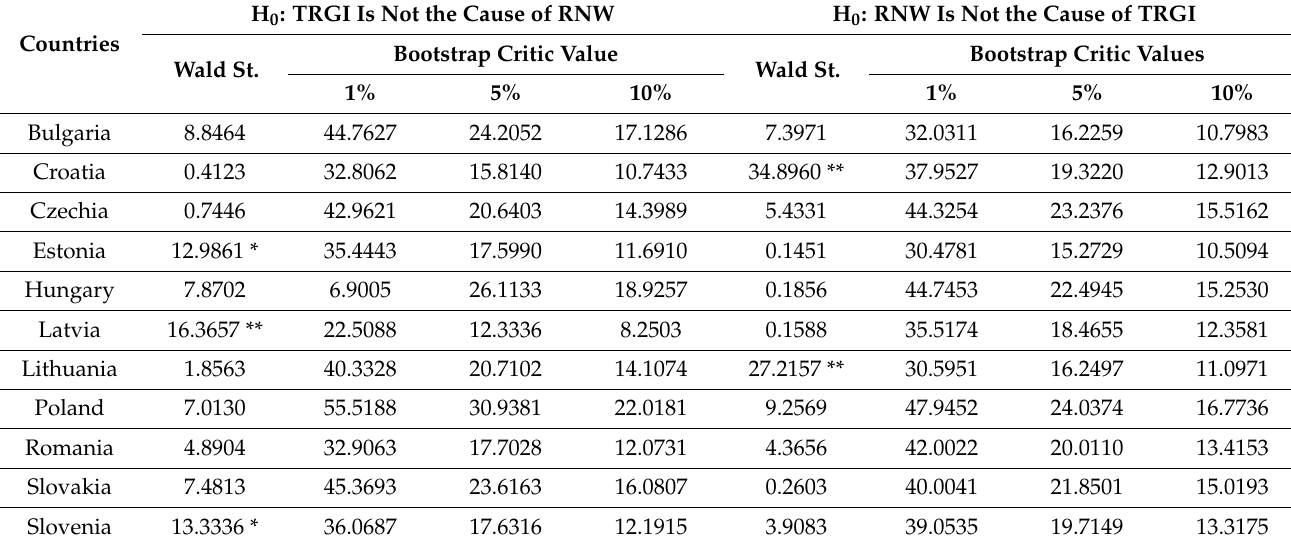
Table 6. Causality analysis between renewable energy and trade globalization.